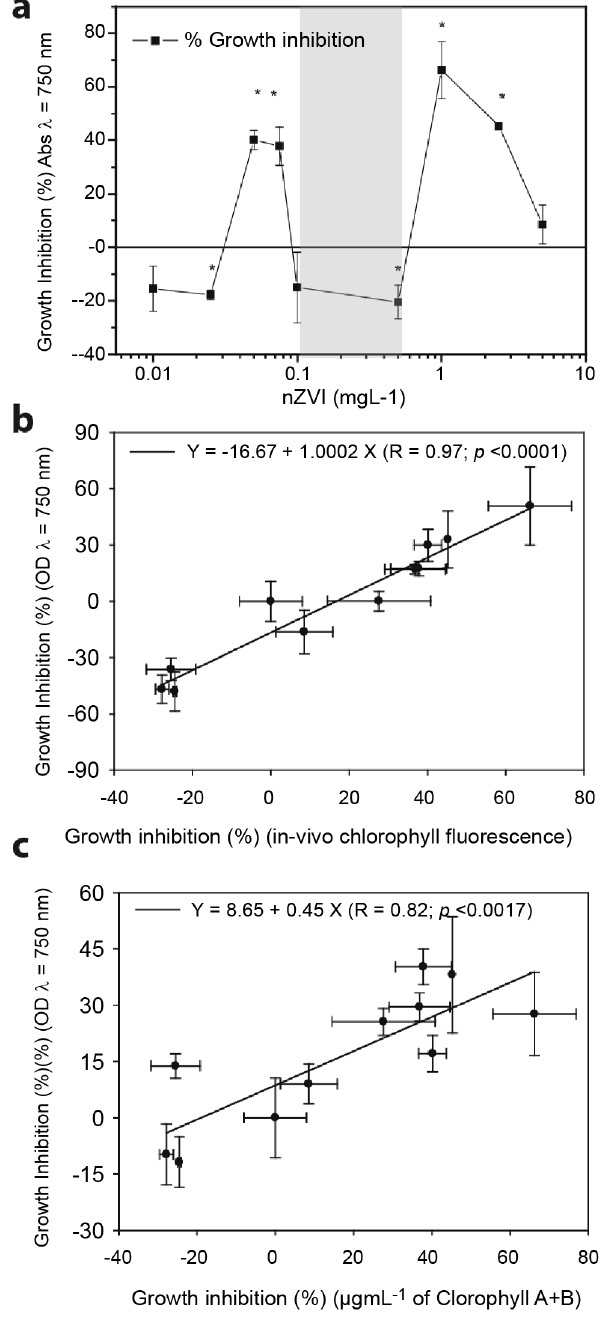
Figure 3. The colloidal singularity prevents nZVI toxicity. (a) Growth inhibition of P. subcapitata exposed to a linear nZVI dose gradient (0.025–5 mgL 2 1 ) based on OD l = 750 nm biomass surrogate. Typically, growth rate of control replicates was 1.4 d 2 1 . The coefficient of variance for 72 h control cultures was 9%. Statistically significant differences ( p , 0.05) are marked by an asterisk. (b,c) Correlations of biomass surrogates for growth inhibition of P. subcapitata exposed to an nZVI dose gradient (0.025–5 mgL 2 1 ). The concentration range in which the colloidal singularity occurred is marked in blue.